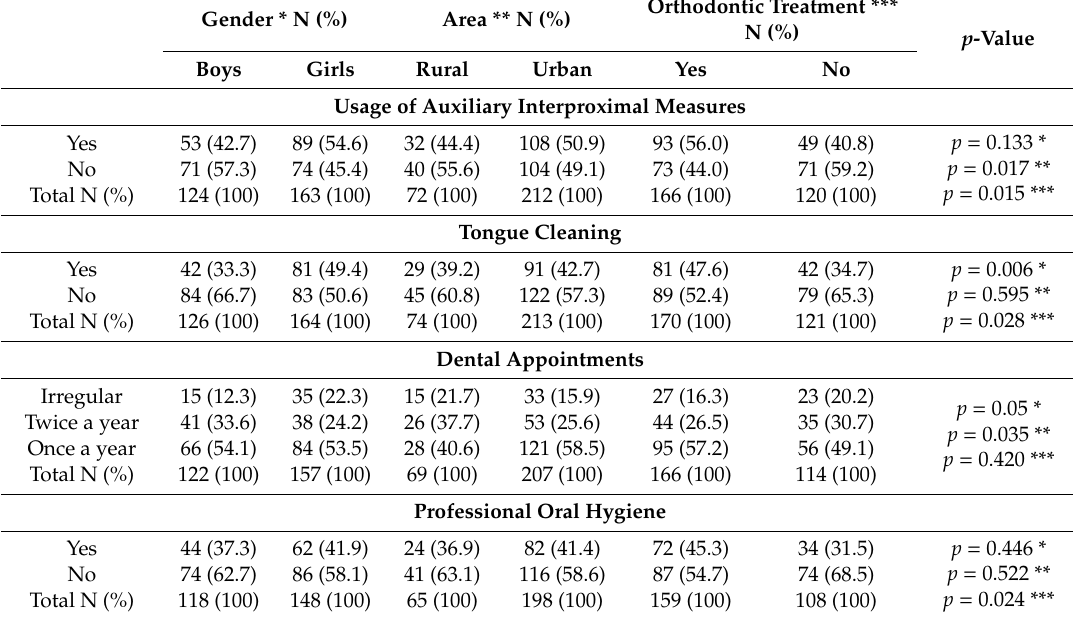
Table 3. Usage of auxiliary self-care measures and attendance to dentists and oral hygienists among participants visiting the Department of Orthodontics at LSMU Clinics.